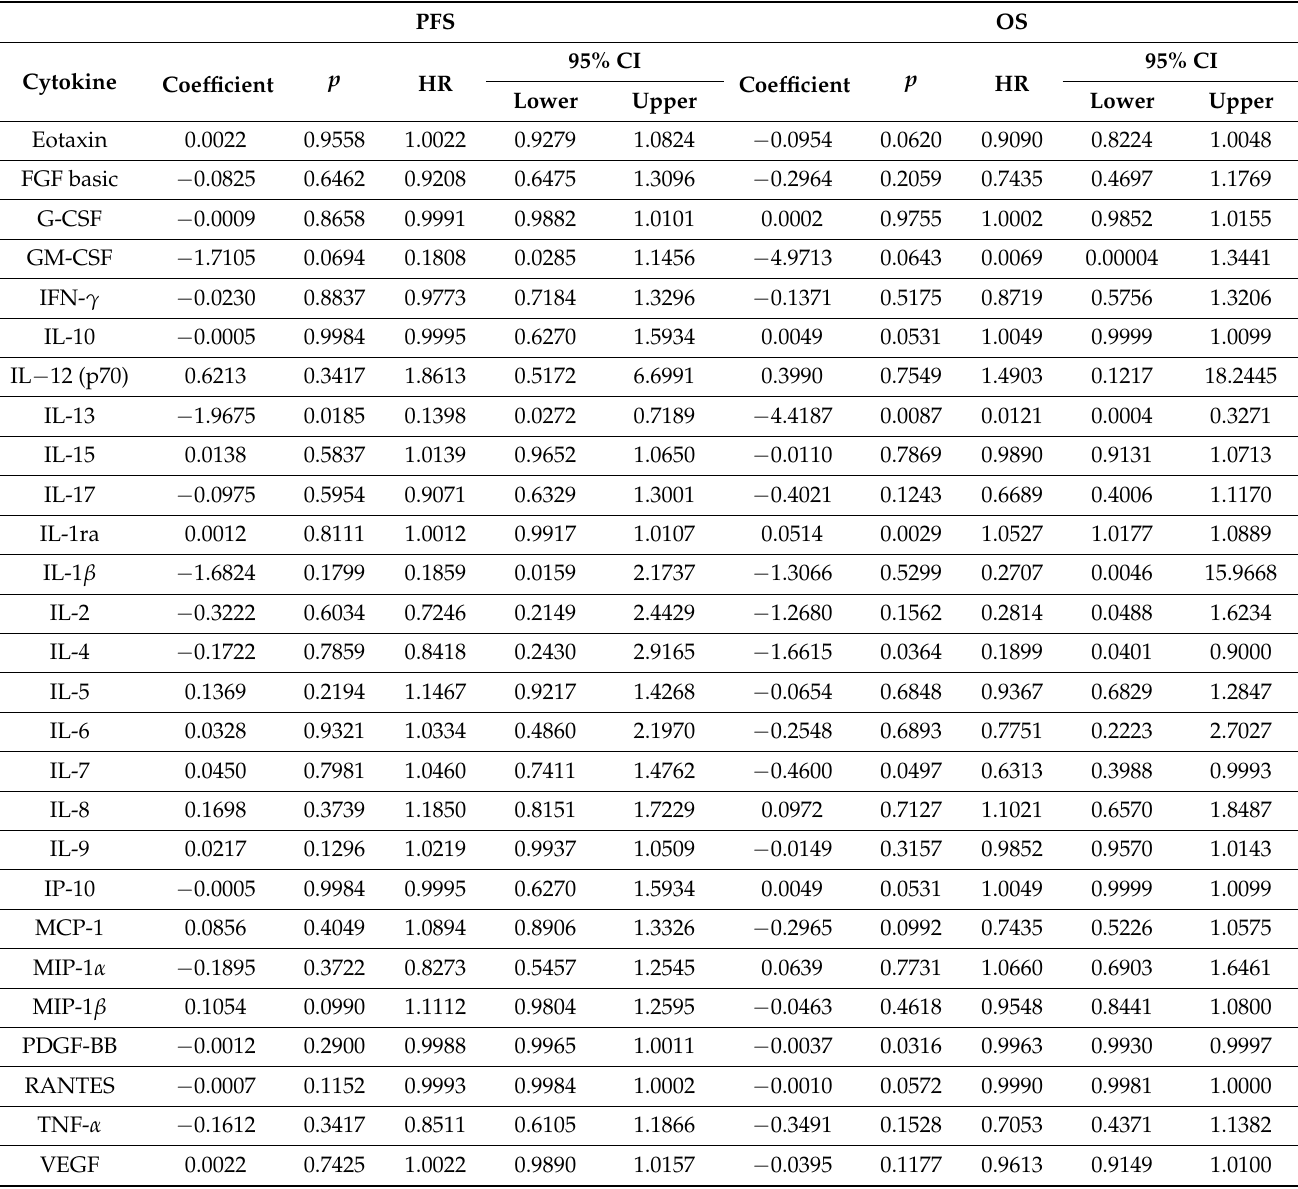
Table 3. Univariate Cox regression analyses of cytokine levels for progression-free survival and over- all survival. Cytokine concentrations (pg/mL) were divided by 10 to allow a more straightforward interpretation of coefficient